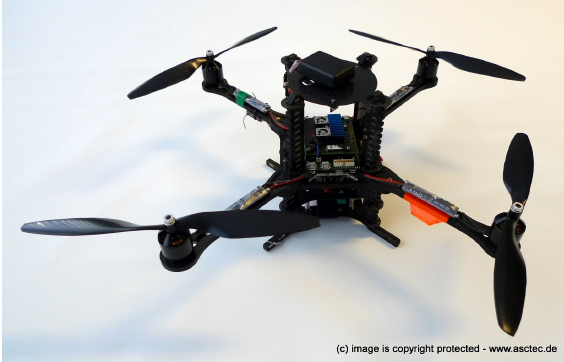
Figure 6: Pelican UAV used in the experiments